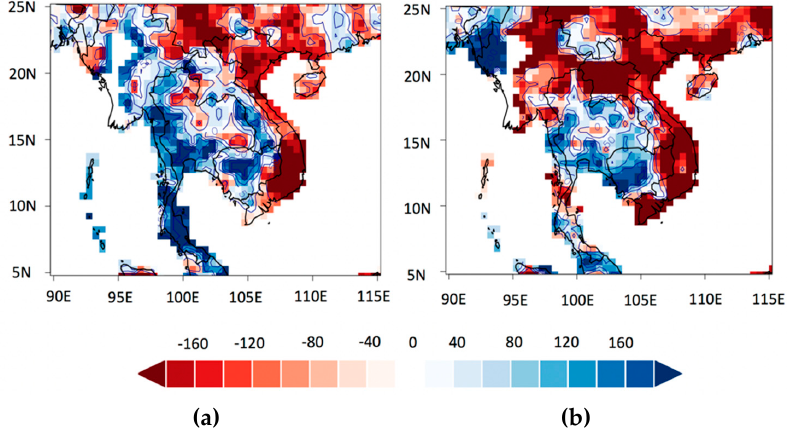
Figure 3. Percentage composite anomalies in extreme drought (departures from the 1981–2010 norms) during ( a ) positive IOD years and ( b ) negative IOD